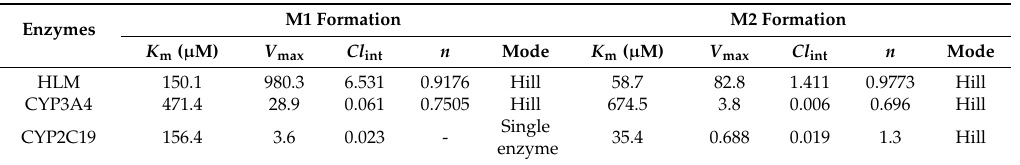
V max : HLM, pmol / min / mg protein; CYP3A4 and CYP2C19, pmol / min / pmol CYP; Cl i nt ( V max / K m ): HLM, µ L / min / mg protein; CYP3A4 and CYP2C19, µ L / min / pmol CYP; n : hill coe ffi